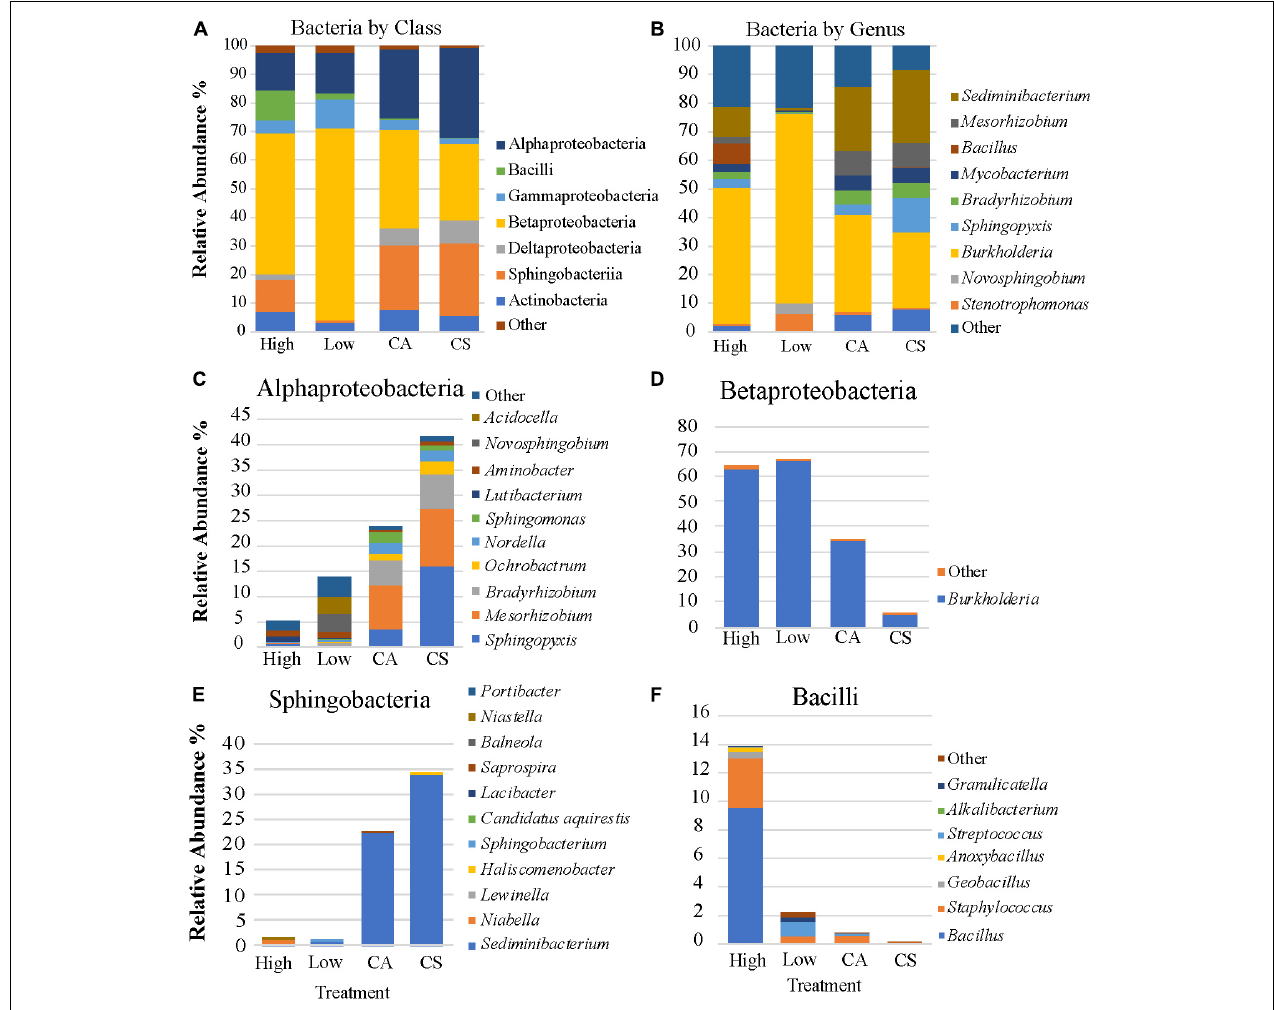
FIGURE 2 | The average relative abundance of the bacterial community members by class (A) , genus (B) , and the genera that comprise the four dominant classes (C–F)